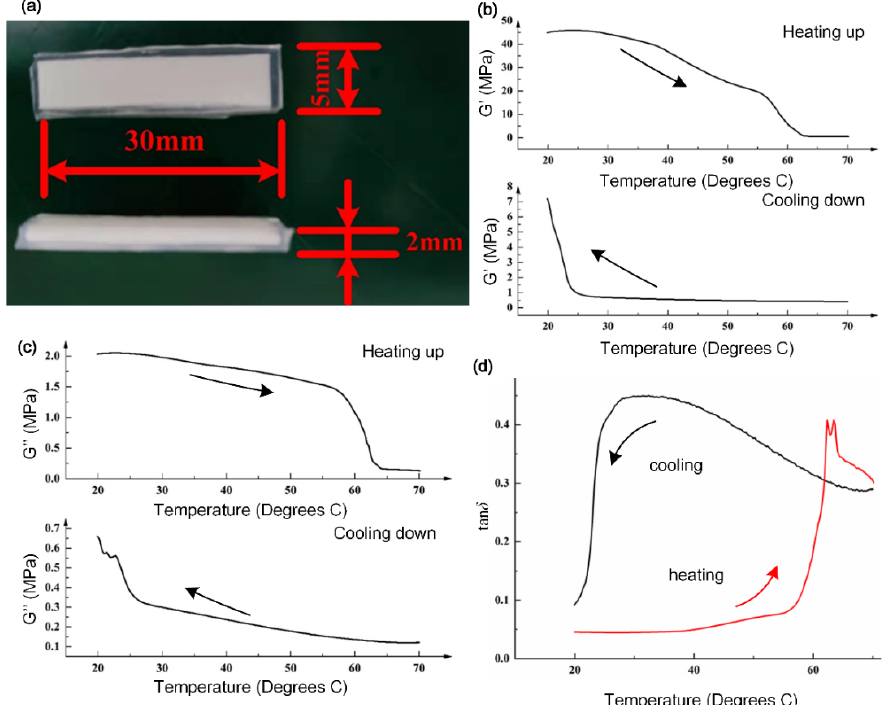
Figure 2. Sample of TPU and DMA test. ( a ) TPU samples encapsulated in PDMS thin films for testing. ( b ) Storage modulus (G’) of the TPU samples with heating up and cooling down processes. ( c ) Loss modulus (G”) of the TPU samples with heating up and cooling down. ( d ) Loss angle ( δ ) of the TPU sample for both heating and cooling processes.